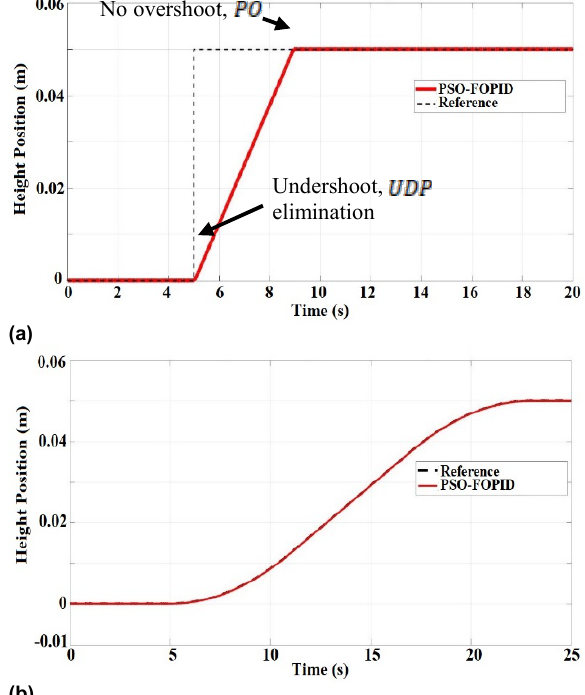
Figure 8. Height position responses of a laboratory scissor mechanism platform for (a) Case III (experiment) and (b) Case IV (experiment) Table 6. Experimental height position characteristics of all controllers for Case III (experiment)